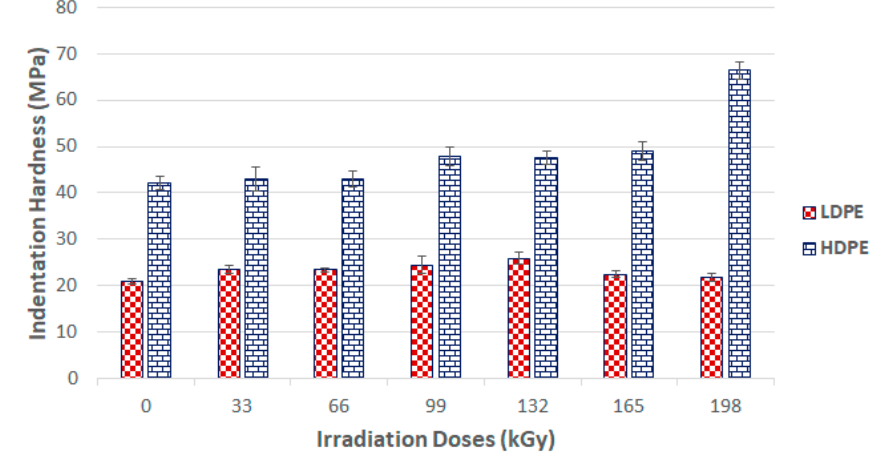
Figure 8. Indentation hardness ( H IT ) of irradiated LDPE and HDPE; the vertical line drawn at the top of the column represents the standard deviation.